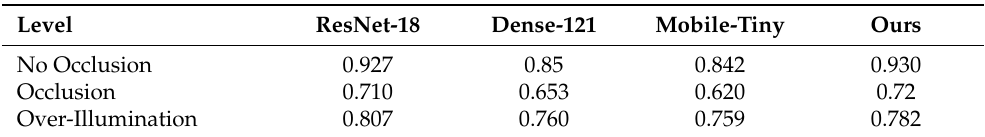
Table 4. The accuracy results of the four comparison models under different Occlusion and illumina- tion